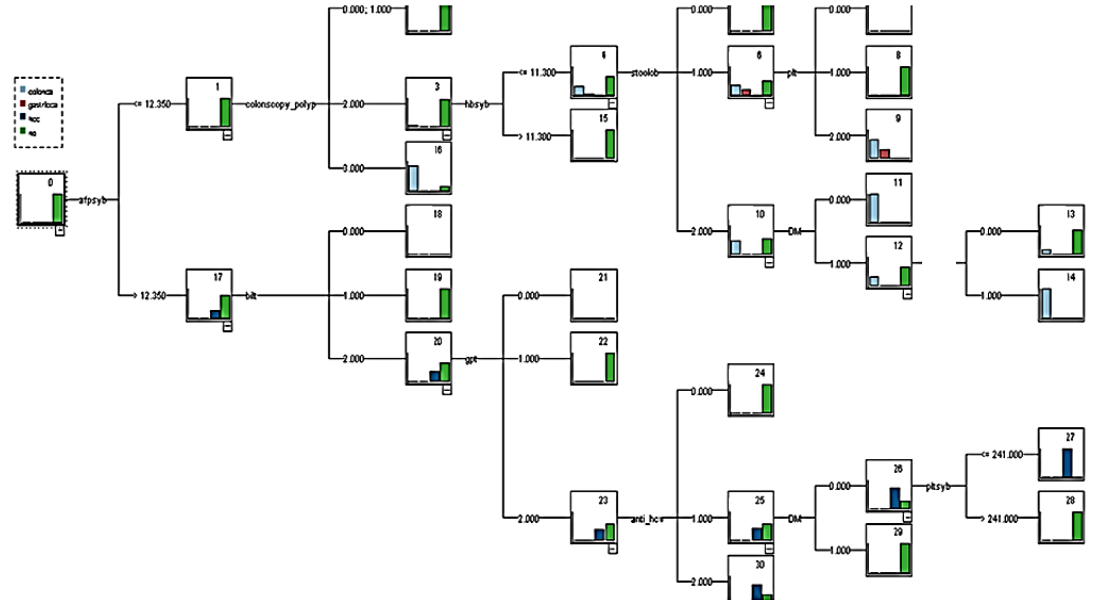
Table 10. Model 1 (no bacterial liver abscess variable) classification results—liver cancer.